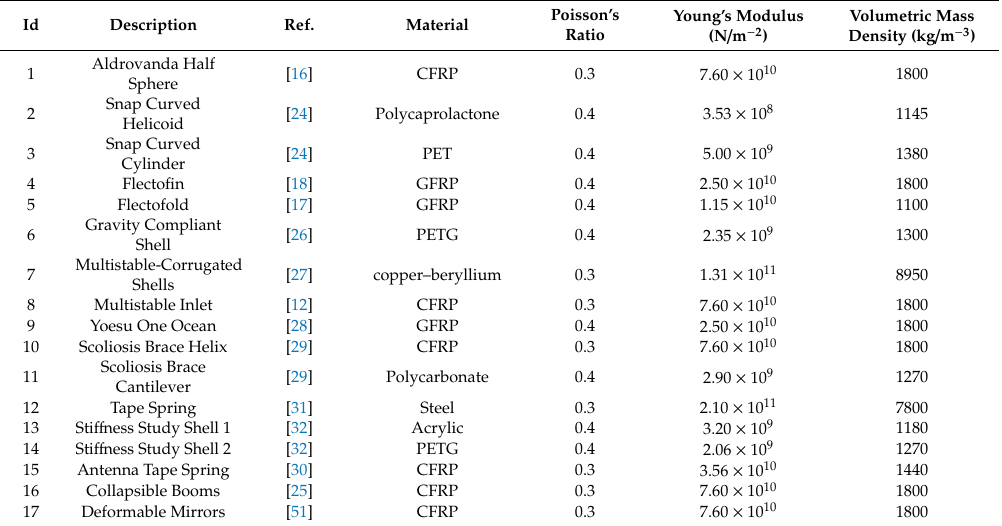
Table A3. Material properties of the compliant engineered thin shells included in the study.